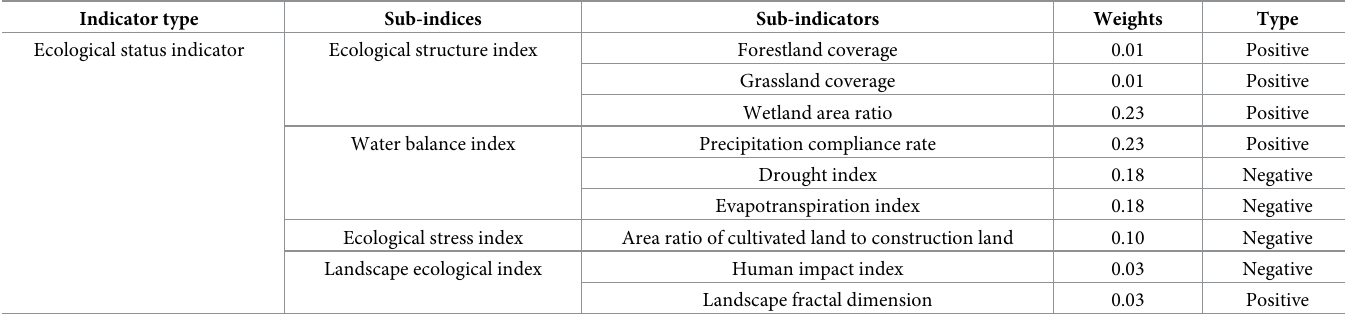
Table 4. Index systems for evaluating water conservation function (improved).